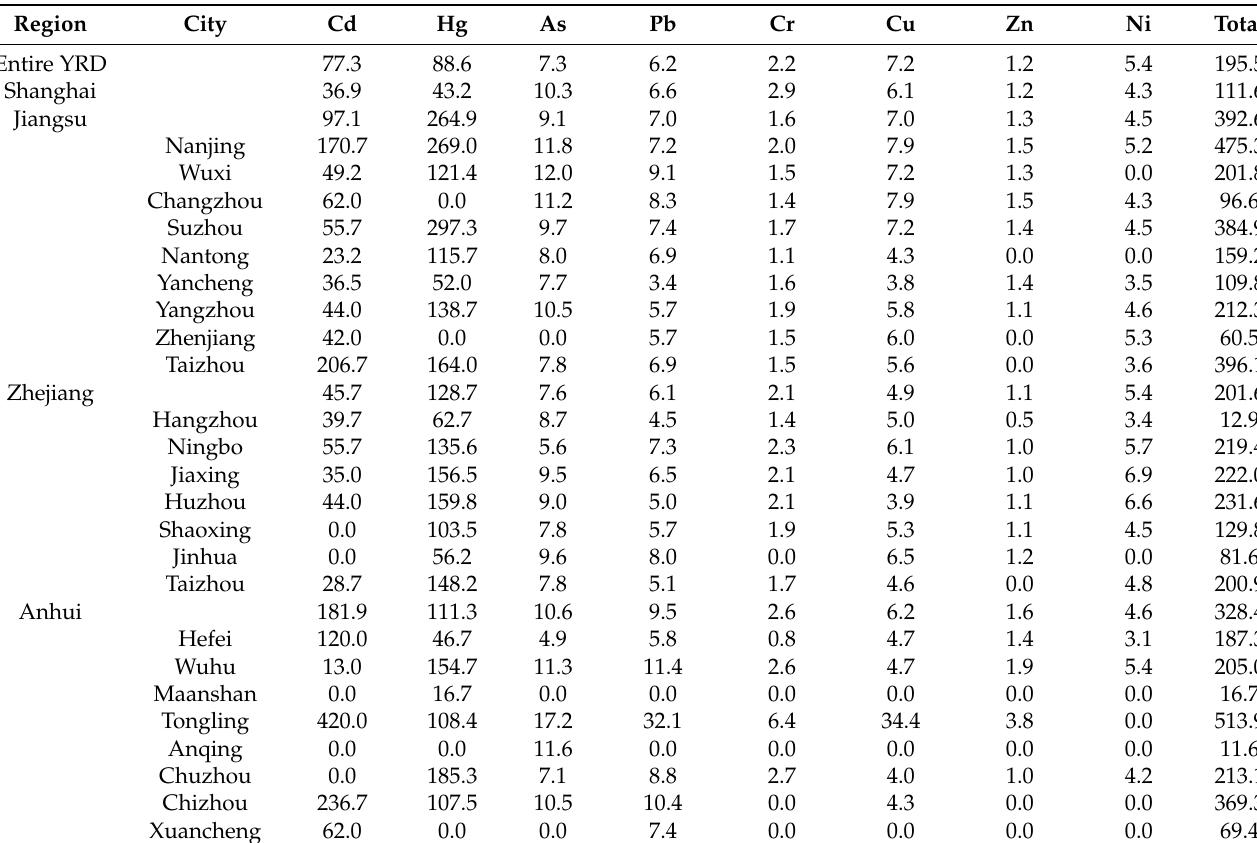
Table 2. The regional ecological risk index (RI) of eight elements in agricultural soil in the Yangtze River Delta (YRD). Region City Cd Hg As Pb Cr Cu Zn Ni Total Entire YRD